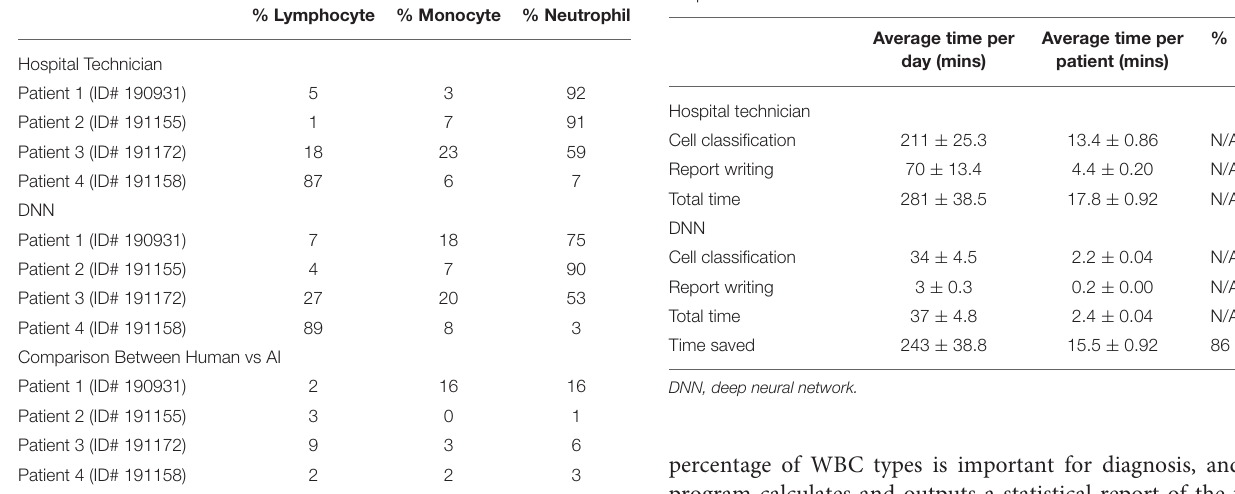
TABLE 2 | Blind testing results of the DNN vs. the Hospital Diagnosis Report. TABLE 3 | The time-saving potential when compared between the DNN and hospital